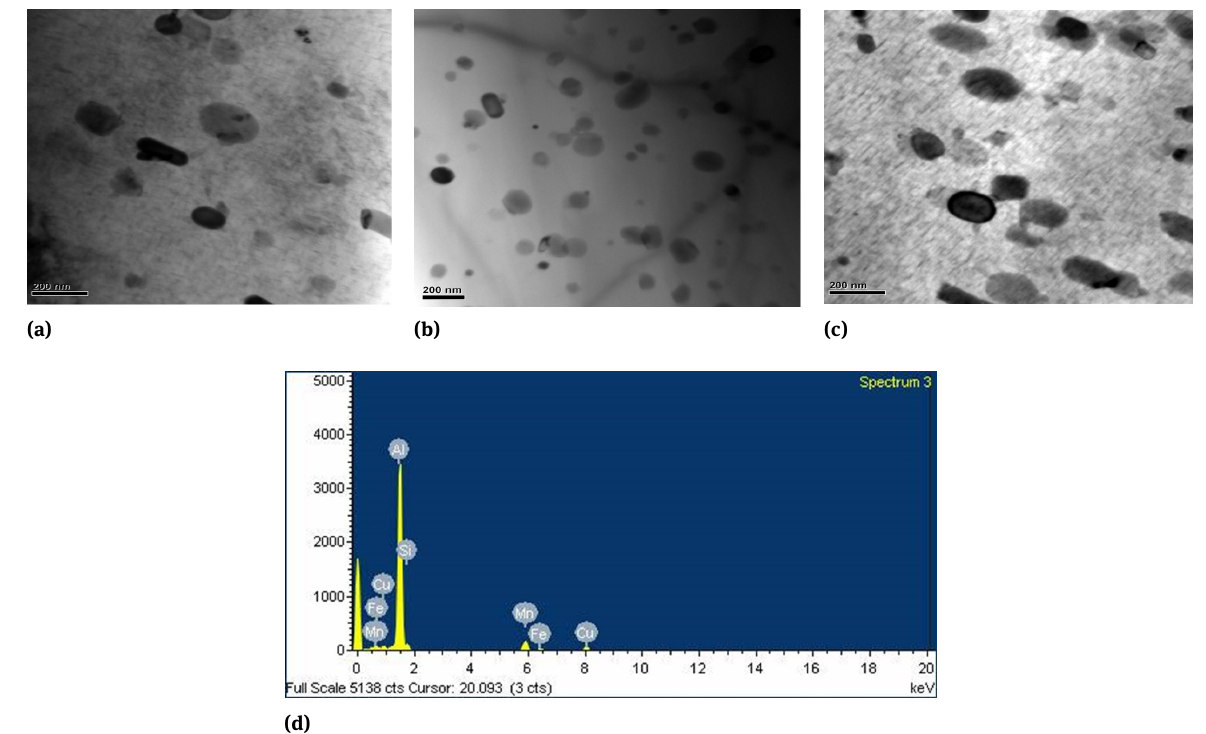
Figure 20: TEM micrograph of a) TMAZ on RS, b) SZ, c) TMAZ on AS, d) EDS result of